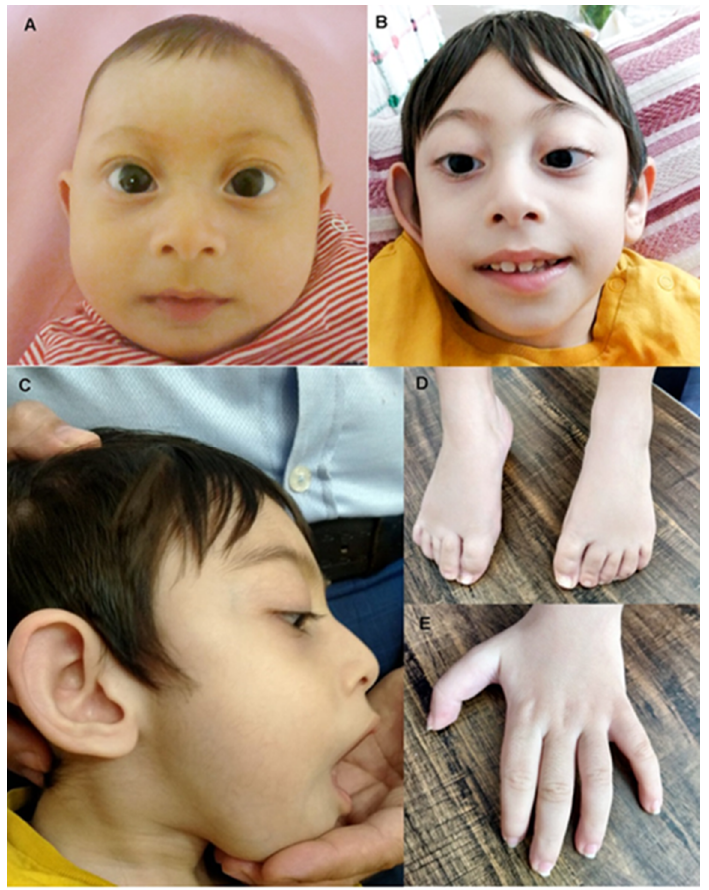
Figure 3. Distinctive features of patient 2. ( A , B ) Frontal view of the face at ages 8 months and 4 years. ( C ) Lateral view of the head at age 4. Microcephaly, retrognatia, ocular proptosis and upslanting palpebral fissures are appreciable. ( D , E ) Foot and hands of the patient at age 4.